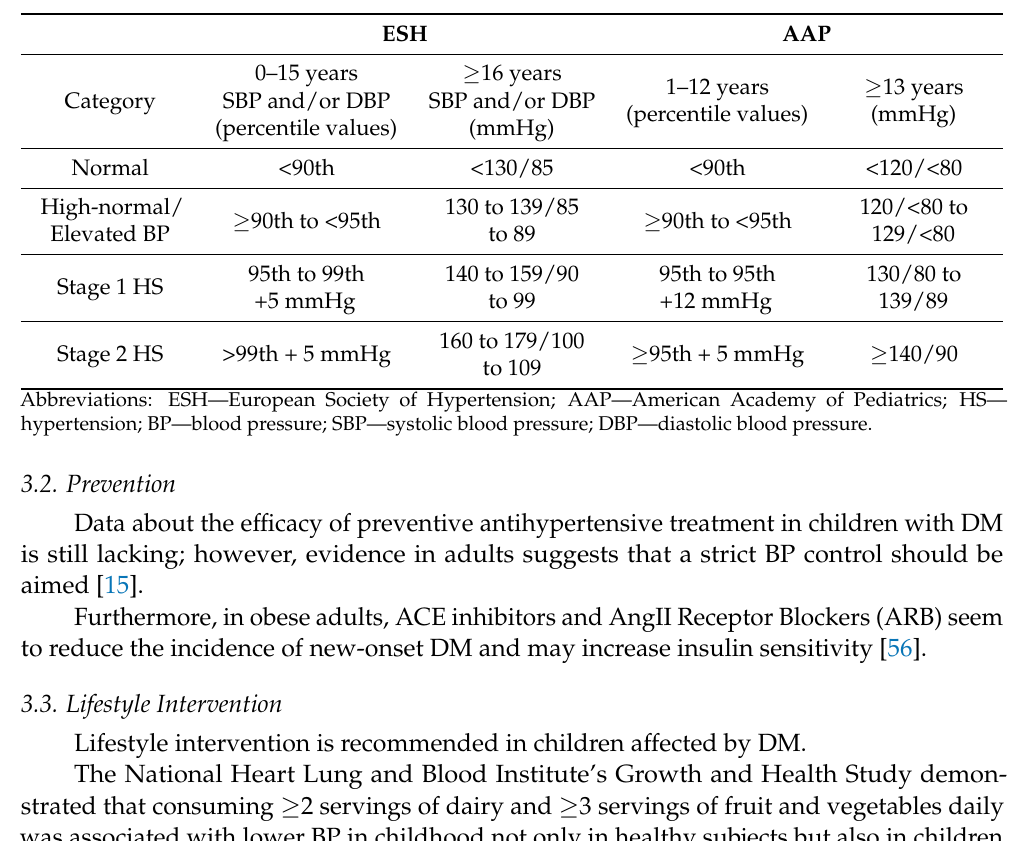
Table 1. Comparison between the ESH’s and the AAP’s definitions of elevated BP and HS in